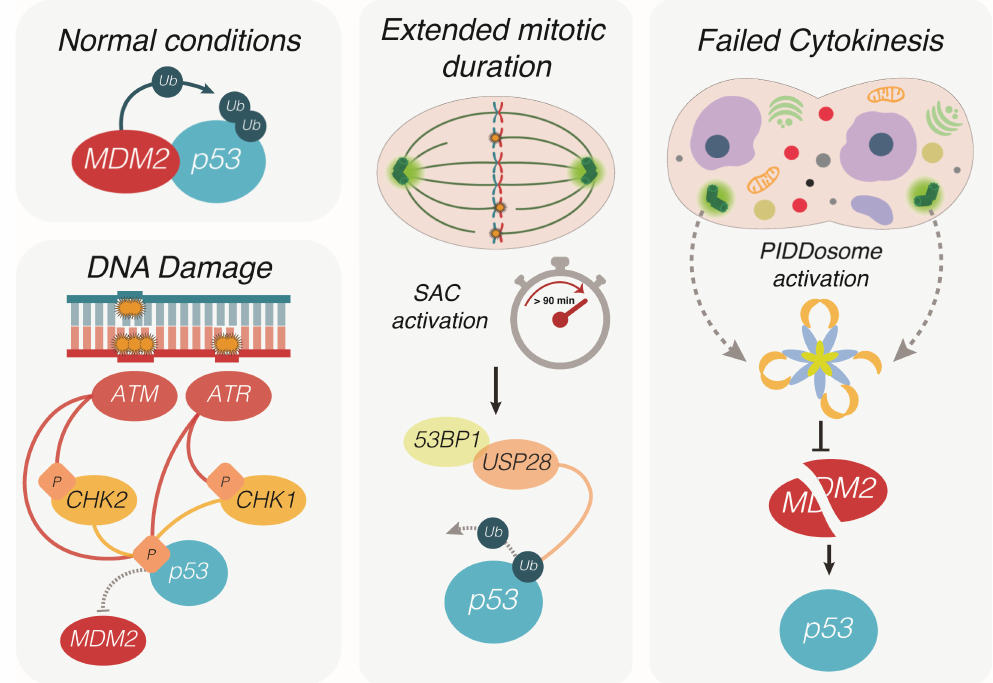
Figure 1. Different routes leading to p53 activation. In physiological conditions, p53 is bound and ubiquitinated by its negative regulator MDM2, which prevents nuclear translocation and promotes its proteasomal degradation. Upon single strand or double strand DNA damage, the kinases ATR and ATM activate the checkpoint kinases Chk1 and Chk2, which contribute to p53 phosphorylation on specific amino acidic residues. Phosphorylated p53 can no longer be bound and degraded by MDM2, resulting in protein stabilization, nuclear translocation and the activation of its transcriptional program. During mitosis, prolonged prometaphase due to the activation of the spindle assembly checkpoint (SAC) is sensed by 53BP1 and USP28. The latter protein promotes de-ubiquitination of p53, arresting the cell cycle in the next interphase. Defective cytokinesis prevents daughter cells to separate completely at the end of mitosis, resulting in a single polyploid cell containing extra centrosomes. The multiprotein complex PIDDosome senses the presence of extra centrosomes and functions as an activating platform for caspase-2. Being a target of this protease, MDM2 is cleaved and thereby inactivated, resulting in the accumulation of p53 and cell cycle arrest of the polyploid